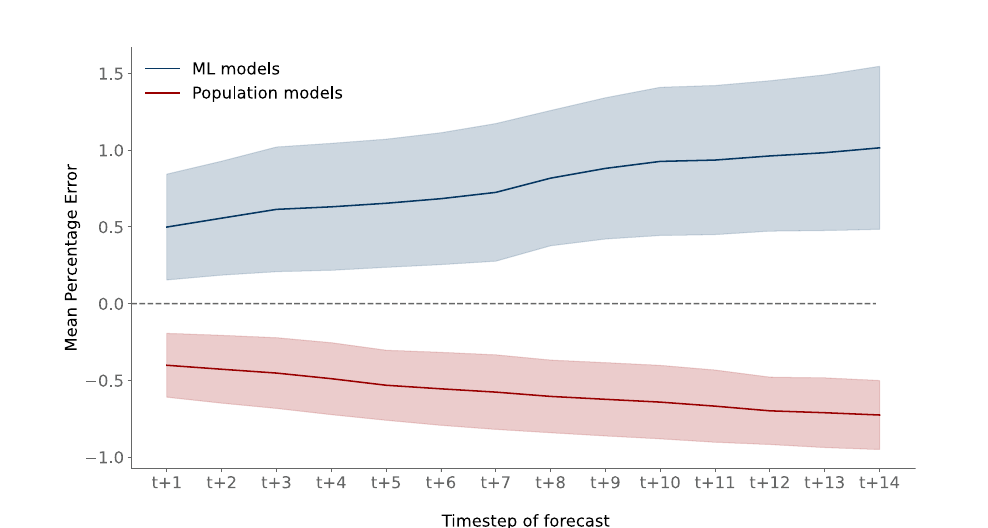
Figure 9. MPE for each time step of the forecast, grouped by model family, for the Spain case in the validation split. Shades show the standard deviation between models of the same family. ML models are trained in Scenario